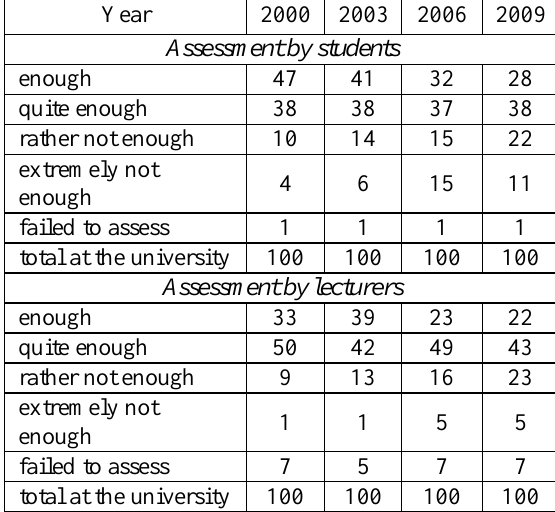
Table 5 . Assessment by students and lecturers